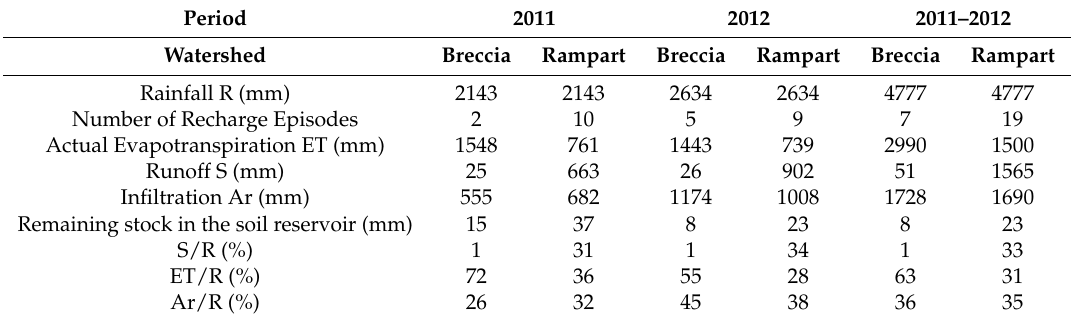
Table 5. Water budget at a yearly scale (years 2011 and 2012) for the breccia and rampart watersheds. The H values for soil reservoirs used for the breccia and rampart watersheds are 250 mm and 50 mm